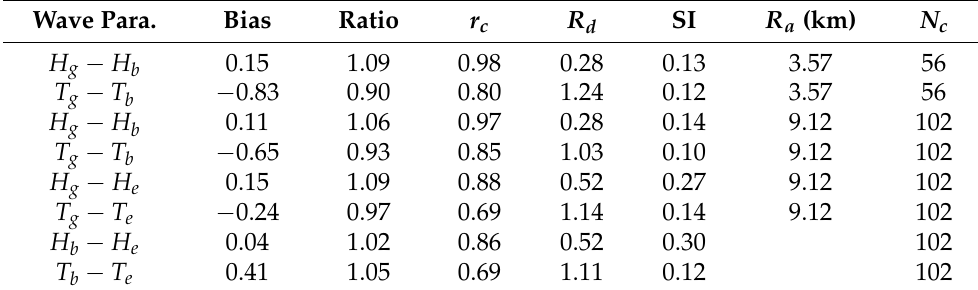
Table 2. Comparisons of the wave parameters of the GPS buoys ( H g , T g ) , drifting buoys ( H b , T b ) and ERA5 ( H e , T e ) . The bias and the ratio for wave parameters X respectively. Unit: m or s for the bias and R d